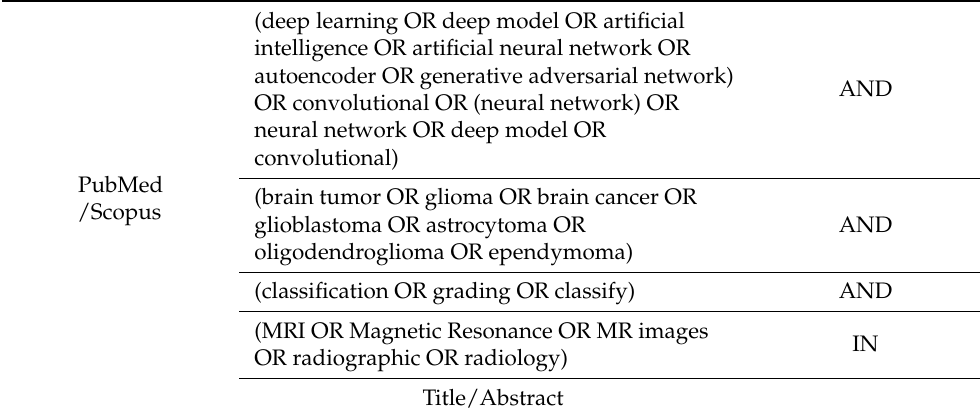
Table 1. The search queries used to interrogate the PubMed and Scopus